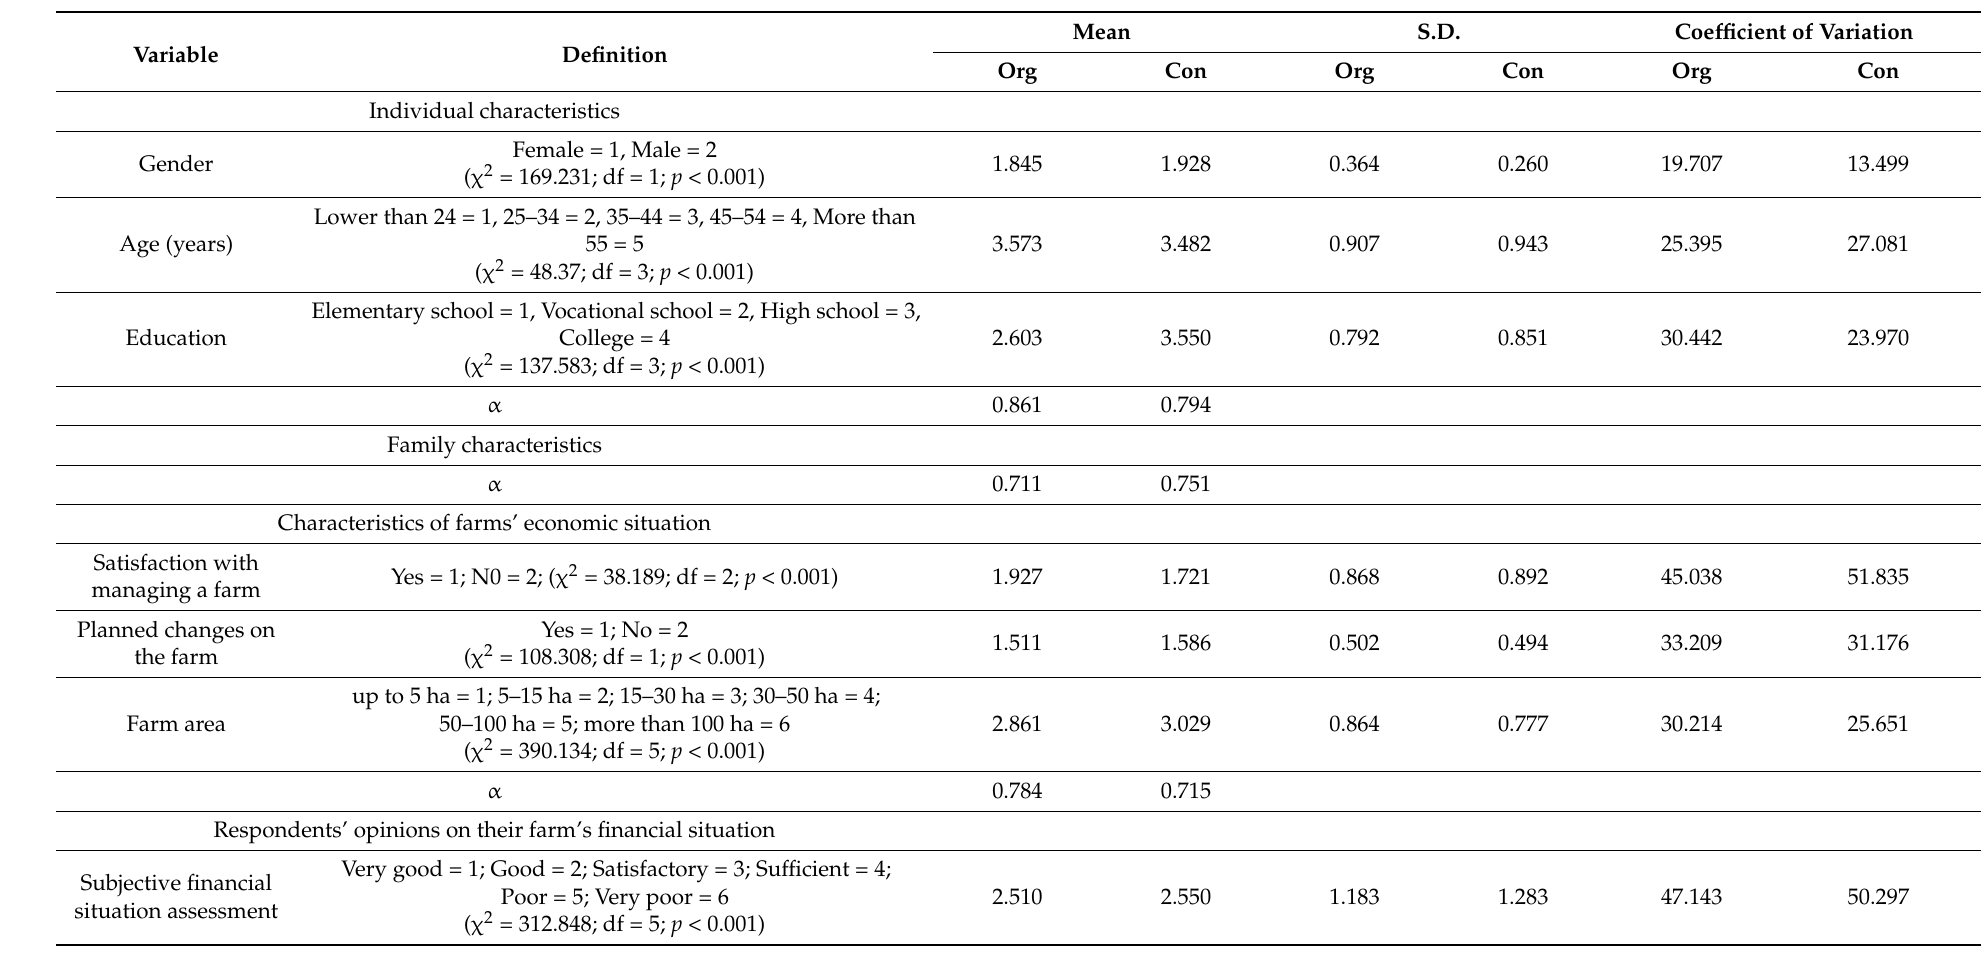
Table A5. Definition, descriptive statistics and Cronbach’s Alpha of the